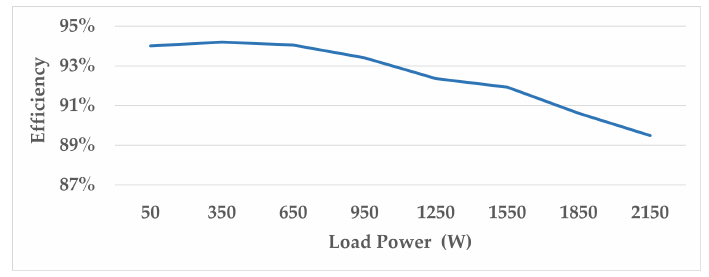
Figure 19. Efficiency versus load for operation modes 1, 5, and